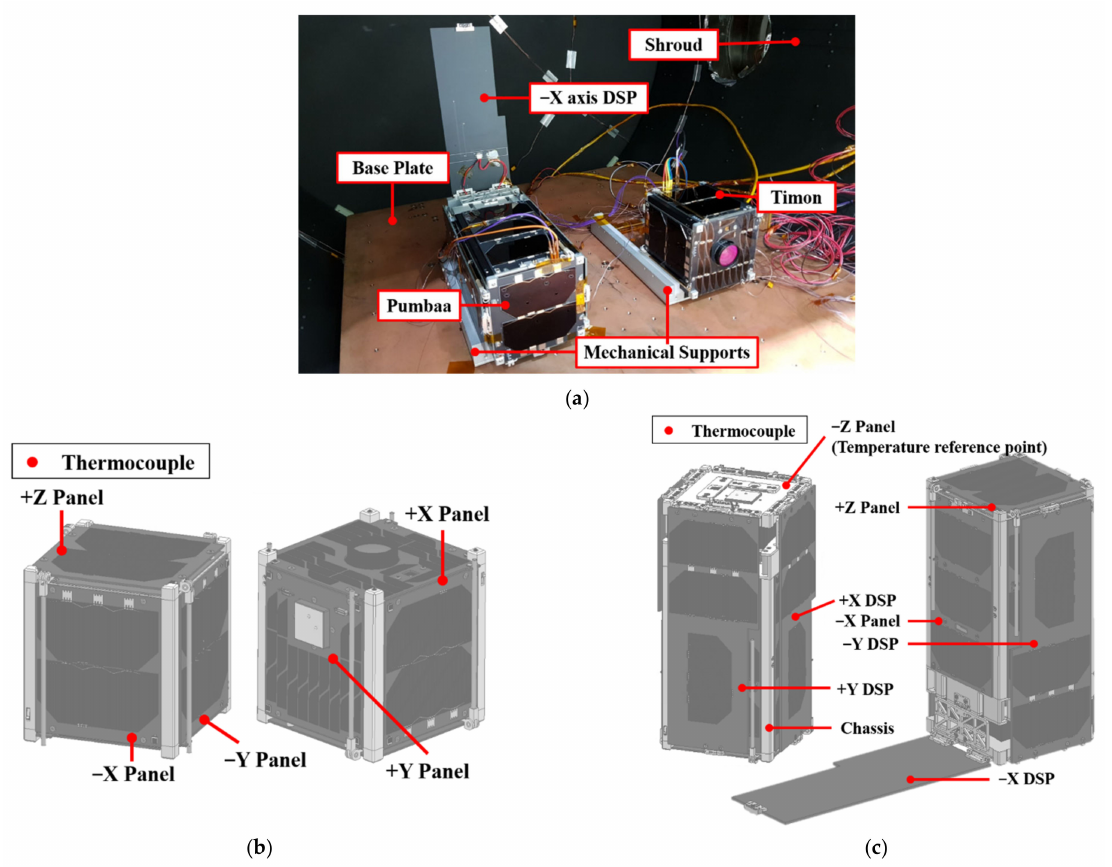
Figure 15. TVCT setting: ( a ) CubeSat arrangement in the chamber; ( b ) TCs on Timon; ( c ) TCs on Pumbaa. The temperature profile of the TVCT is controlled by the temperature reference point (TRP) attached to a thermally stable point [26]. During the TVCT, the Z-axis aluminum panel on Pumbaa was set to the TRP following the results of the on-orbit thermal analysis. The temperature range of the TVCT was set from − 15 ◦ C to +30 ◦ C, and the vacuum pressure was set lower than 4.0 × 10 − 7 bar. Figure 16 shows the TVCT procedure, which involves 2.5 cycles and a dwell time of 3 h. During the dwell time, functional tests were carried out, including the operations of each component, formation flying algorithm computation, and firing of the PPS; in the cold case, the heaters on the PPS were evaluated by varying the duty rate. The total mass loss (TML) of the CubeSats was measured to be 4 g, and the TML was 0.36% of the total mass of Timon and was 0.16% of the total mass of high-vacuum space environment